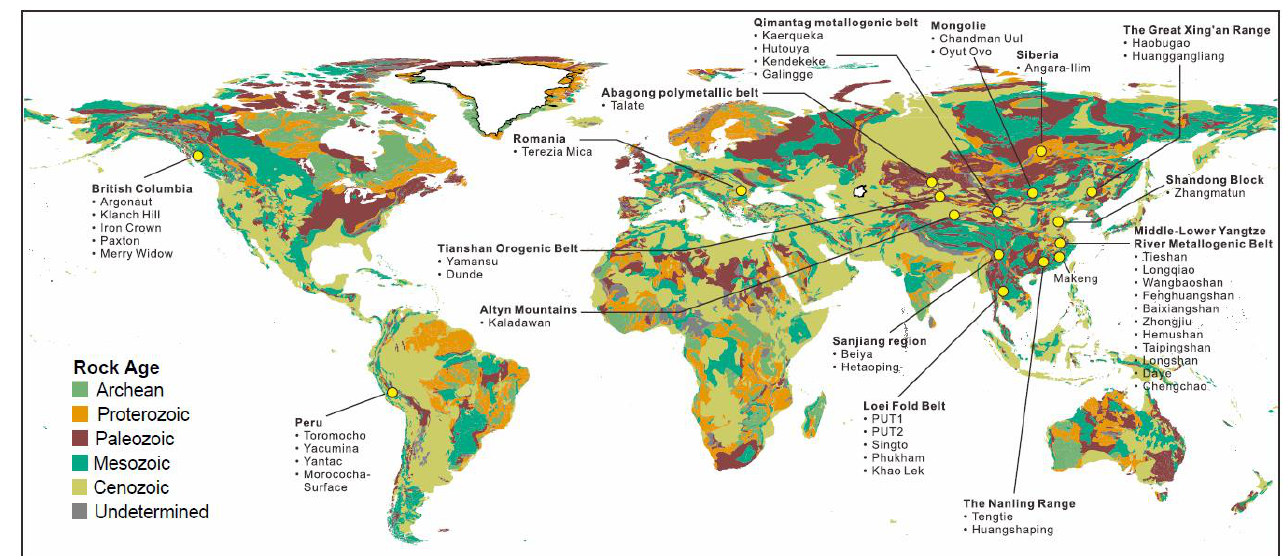
Figure 1. Distribution of the skarn deposits collected in this study. The physical map of world is from M. Colpron (Geological Survey of Canada, Ottawa, ON, Canada).